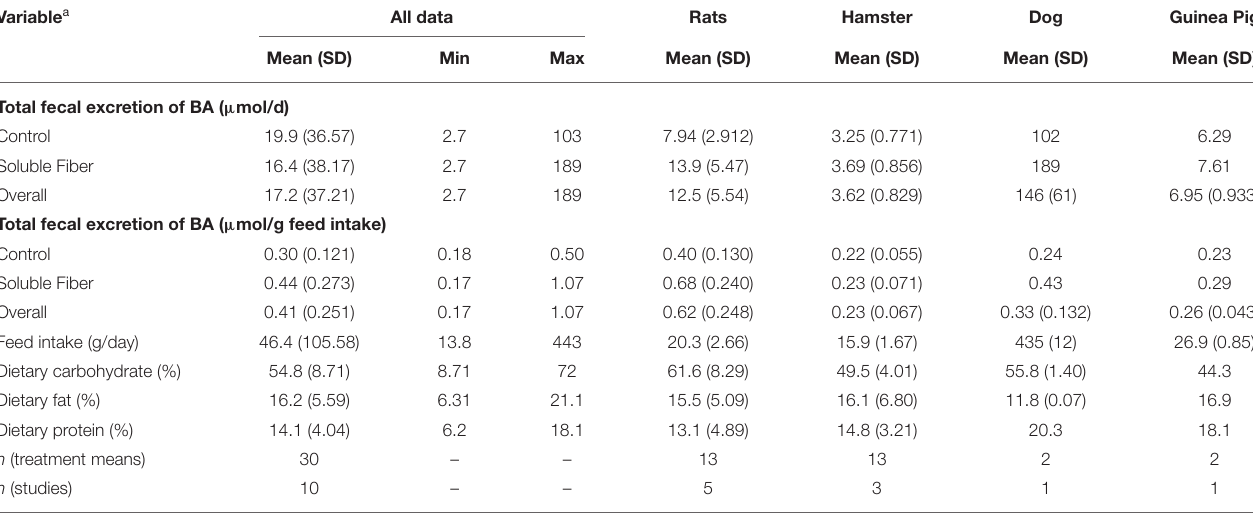
TABLE 2 | Descriptive statistics of the dependent and independent variables in the dataset. Variable